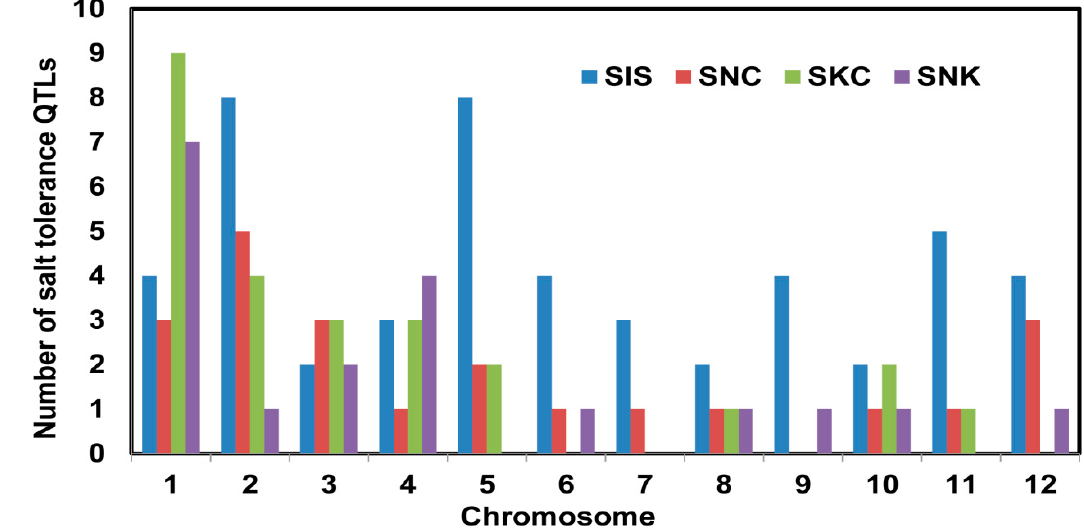
Figure 1. Number and distribution of initial quantitative trait loci (QTLs) for four salt-tolerance traits on 12 chromosomes in rice based on 12 QTL mapping studies. SIS, salt injury score; SNC, shot sodium concentration; SKC, shoot potassium concentration; SNK, shoot sodium–potassium ratio.